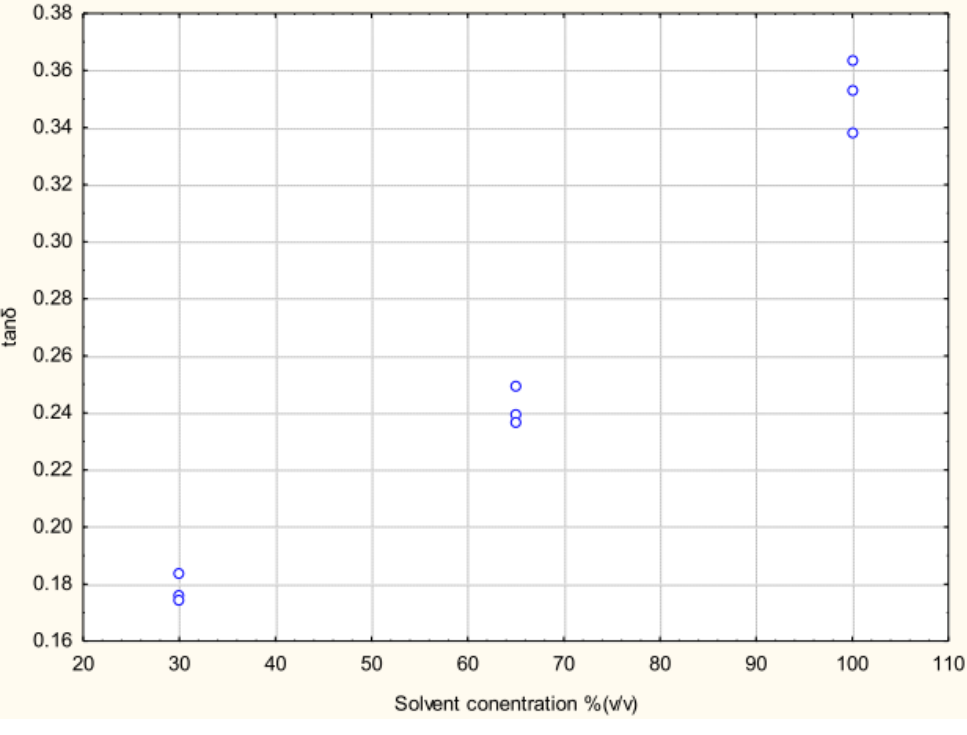
Figure 10. Effect of solvent concentration on total phenolic yield after extraction for 5, 10 and 15 min during the microwave-assisted extraction (MAE) process (Source: Adapted from